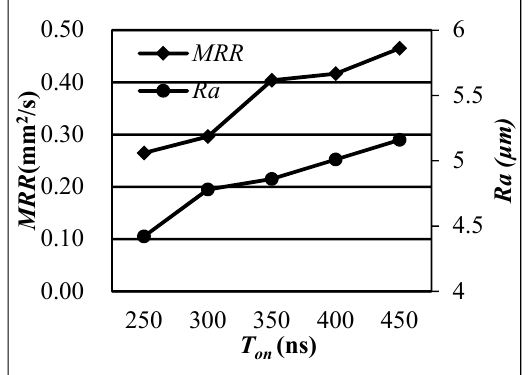
Figure 4. The effect of T on on MRR and SR.